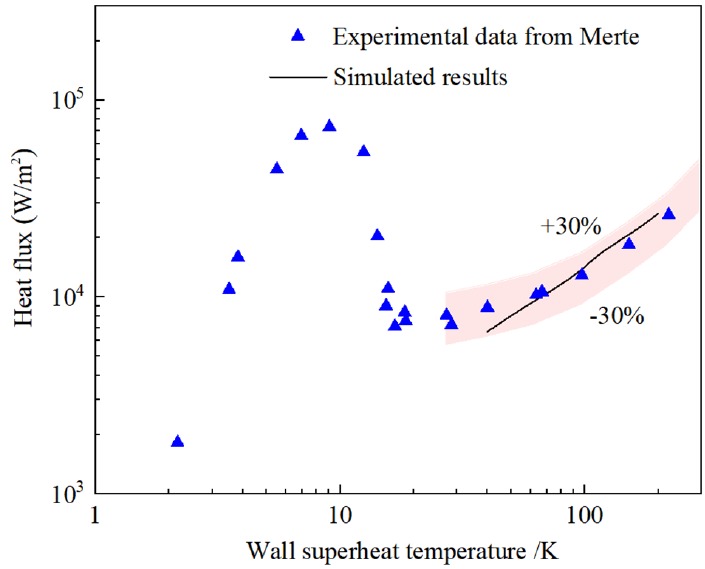
Figure 5. The comparison of calculated results and experimental data [46].